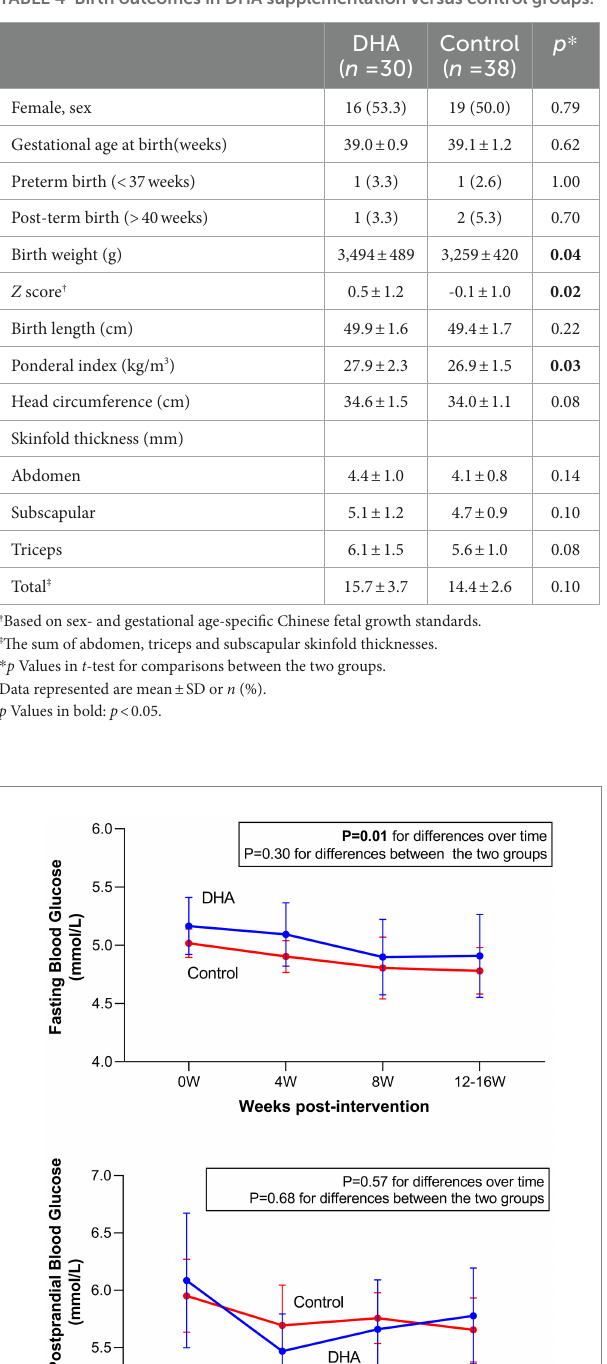
TABLE 4 Birth outcomes in DHA supplementation versus control groups.